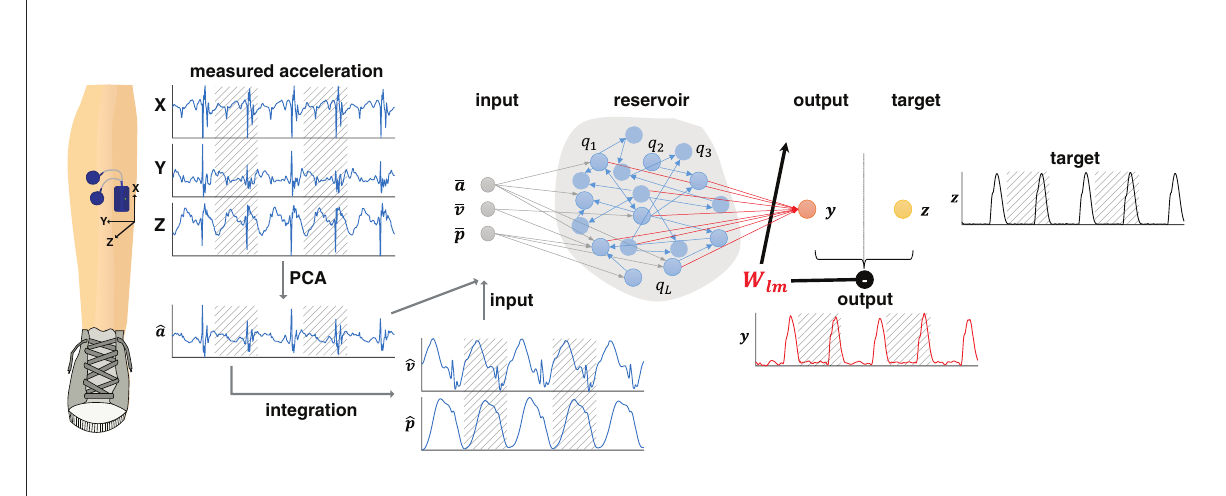
FIGURE1 A reservoir computer was implemented to predict the vertical ground reaction forces. Tri-axial accelerometer data were recorded from the shank. The accelerometer data were re-oriented using a principal component analysis (PCA). The first prinicipal component (â) was integrated once to obtain the velocity ( ˆ v) and position ( ˆ p) data. The input x consisting of the normalized accelerometer (a), velocity (v), and position (p) data were subsequently mapped onto the sparsely, randomly connected reservoir q. This reservoir generated the output y, the predicted normalized vertical ground reaction forces (in red), via output weights W. When training, the output was compared to the target z, i.e., the measured vertical ground reaction forces (in black). Minimizing the difference between generated output and target served to adjust the weights (denoted here as W lm ). For training, data were segmented into strides, here represented by hatched and unhatched areas. Testing was conducted on continuous data. Data from walking and running were pooled.